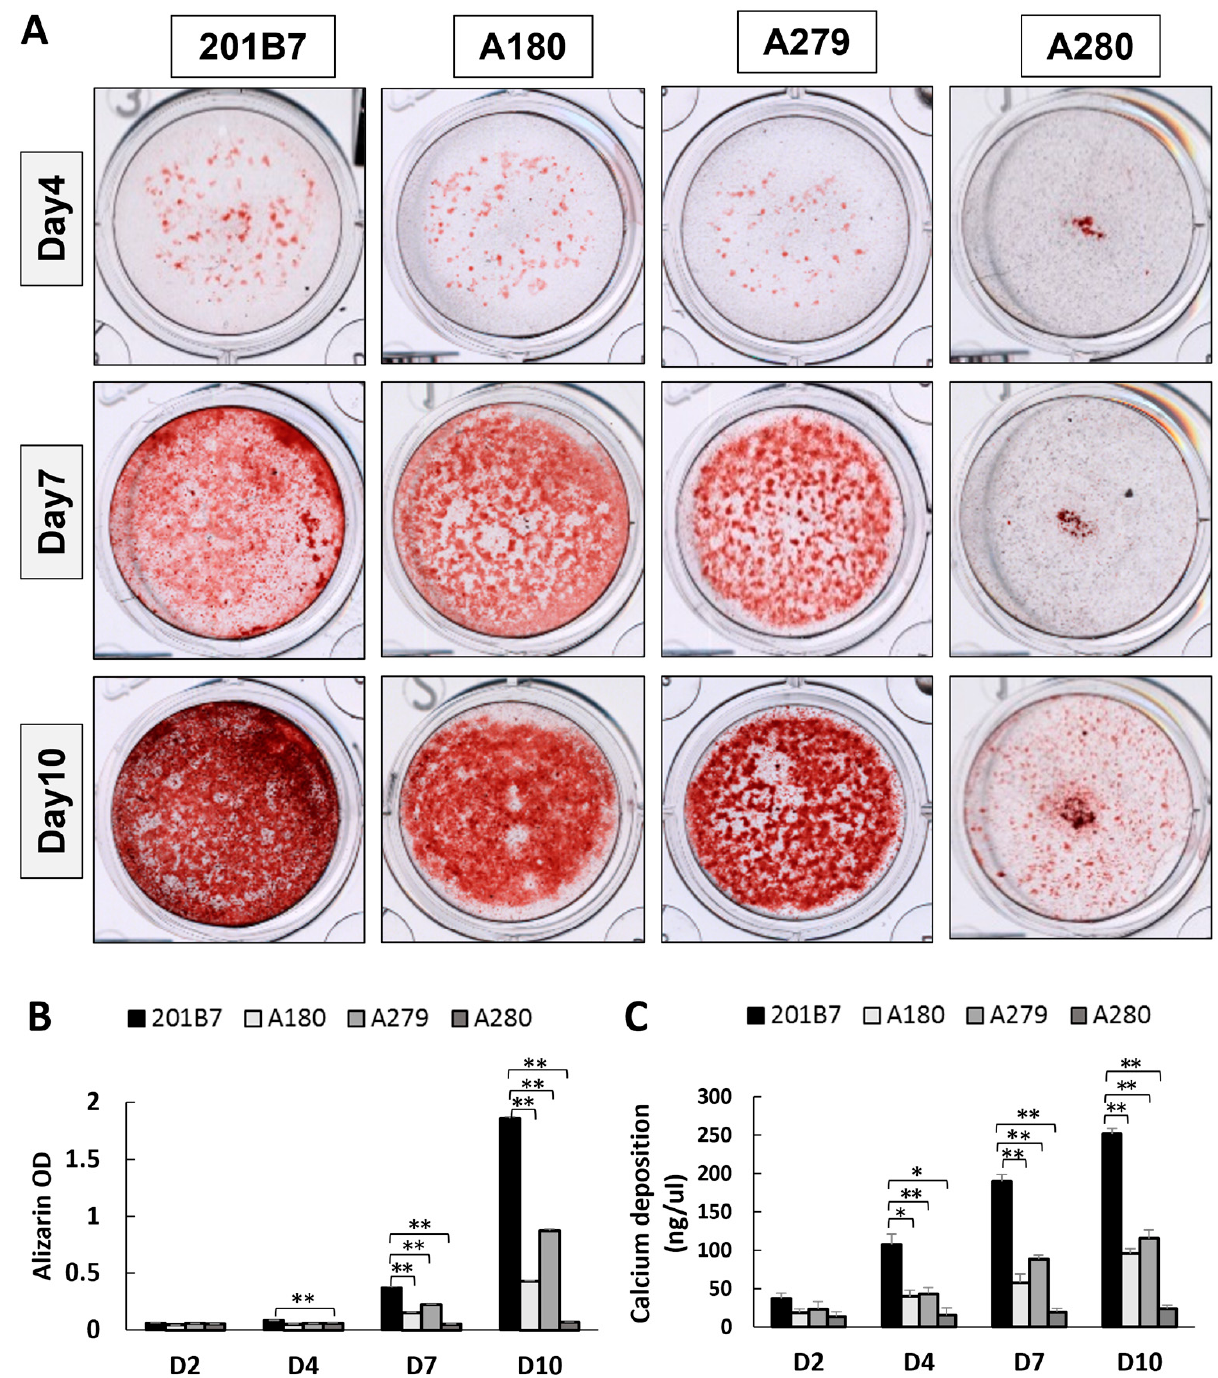
Figure 3. Impaired osteogenesis in mcEDS- CHST14 iPSCs. ( A ) Representative images of alizarin red staining (red granules) in WT and mcEDS- CHST14 iPSCs during osteogenic differentiation. Evaluation of bone formation on the indicated day was quantified with dissolved alizarin solution ( B ) and the deposition of calcium ( C ). Results were normalized to cell number. Data expressed as the mean ± SD ( n = 3); * p < 0.05, ** p < 0.01.